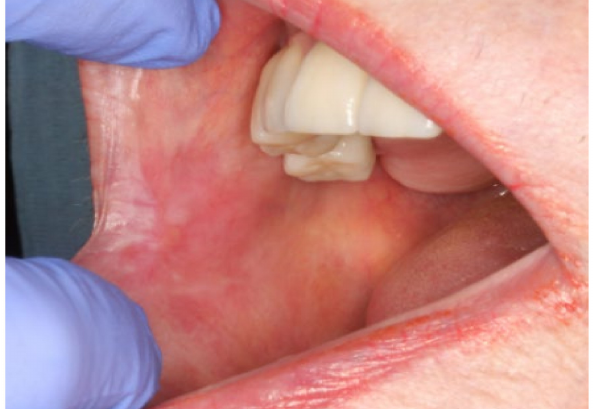
Figure 4. Two weeks after the last infiltration: complete resolution of the lesion.